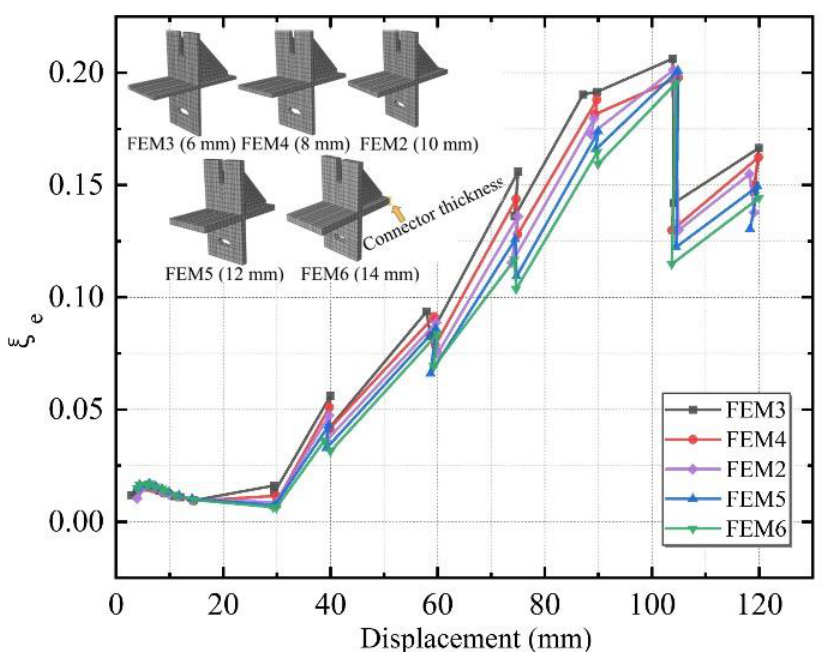
Figure 18. The equivalent viscous damp ratio for specimens with different thicknesses.